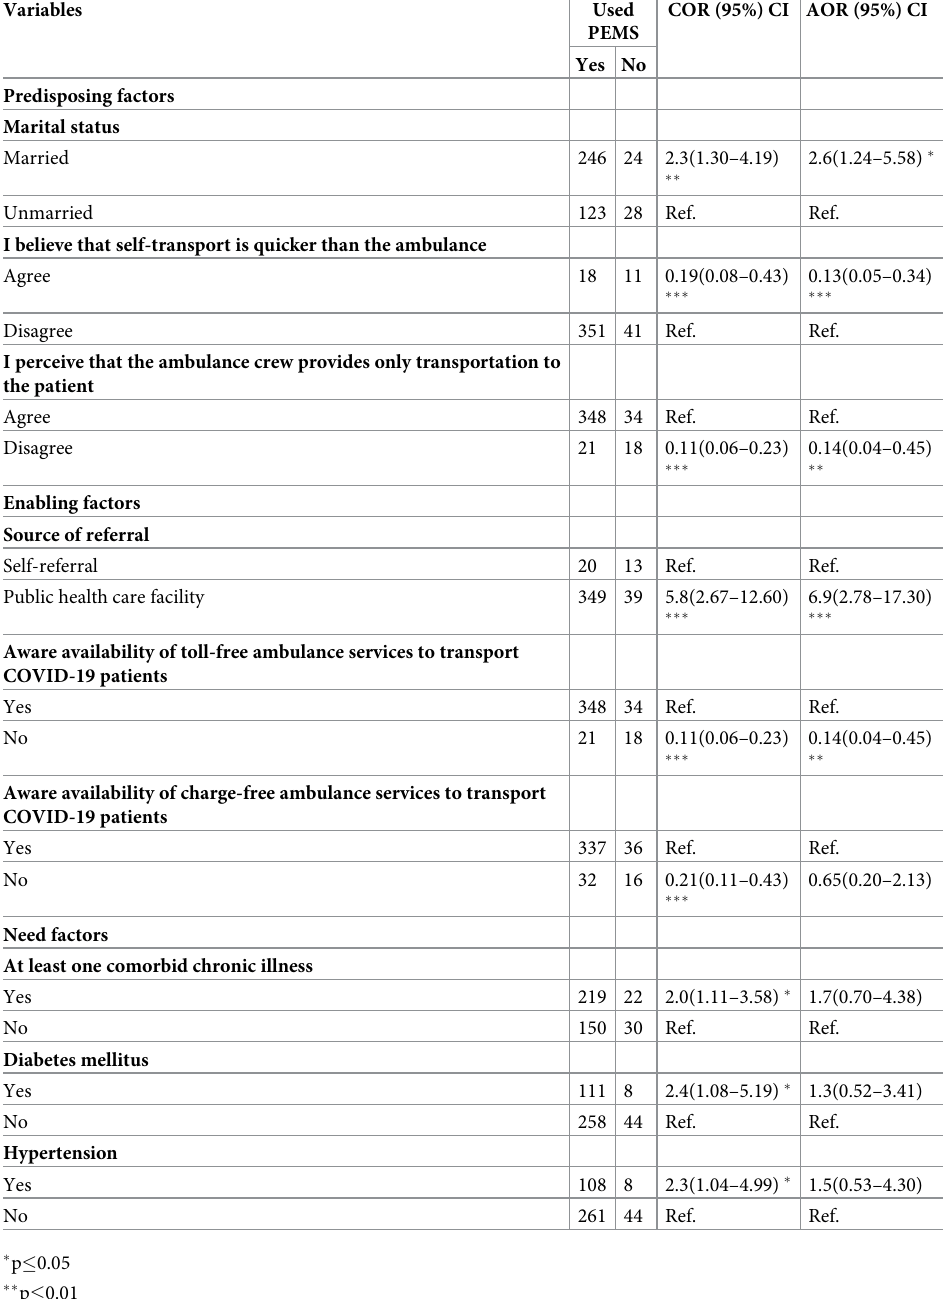
Table 6. Bivariate and multivariate logistic regression analysis of factors associated with prehospital care utiliza- tion among severe and critical COVID-19 patients treated in centers in Addis Ababa, Ethiopia, from May to July